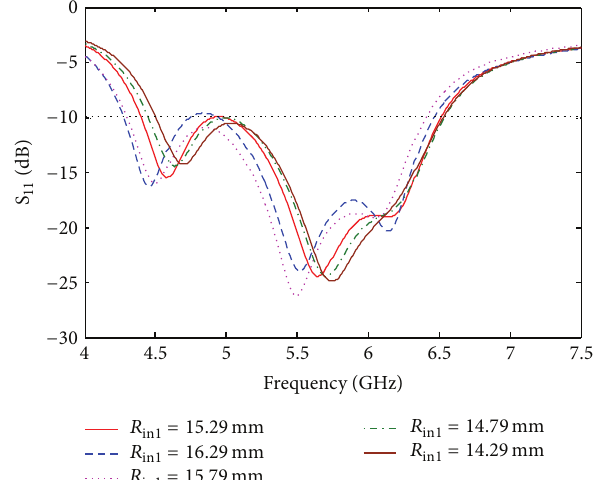
Figure 5: Frequency behavior of the magnitude of the reflection coefficients as a function of the inner diameter 𝑅 2.35 mm, 𝐿 = 21.79 mm, 𝑃 𝑥 = 3.85 mm, 𝑅 = 10.09 mm. 8.70 mm, and 𝑅 out 2